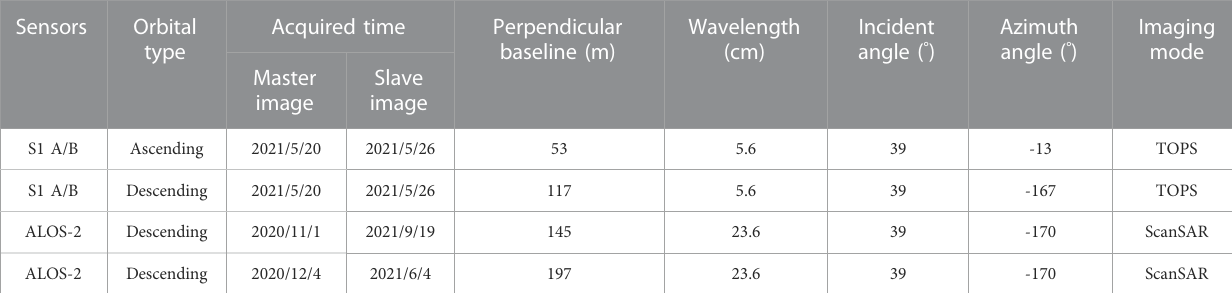
TABLE 1 Basic information of SAR data used